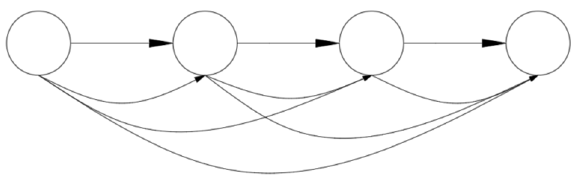
Figure 5. Dense connection mode of DenseNet model.